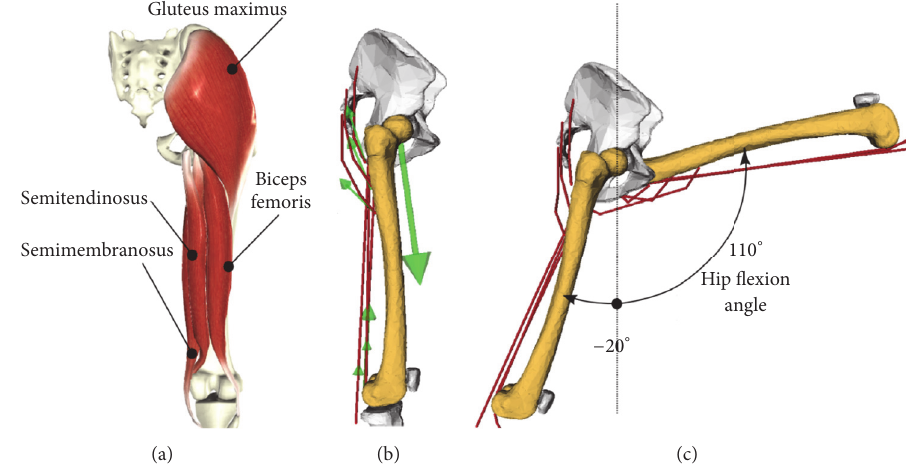
Figure2:Fromthelefthandside,(a)theanatomicalrepresentation(posteriorview)ofthehipextensormusclestakenfromBioDigitalHuman (https://human.biodigital.com); (b) the model in the anatomical position (lateral view) including the muscle and hip forces (in green); and (c) the range of hip flexion angles